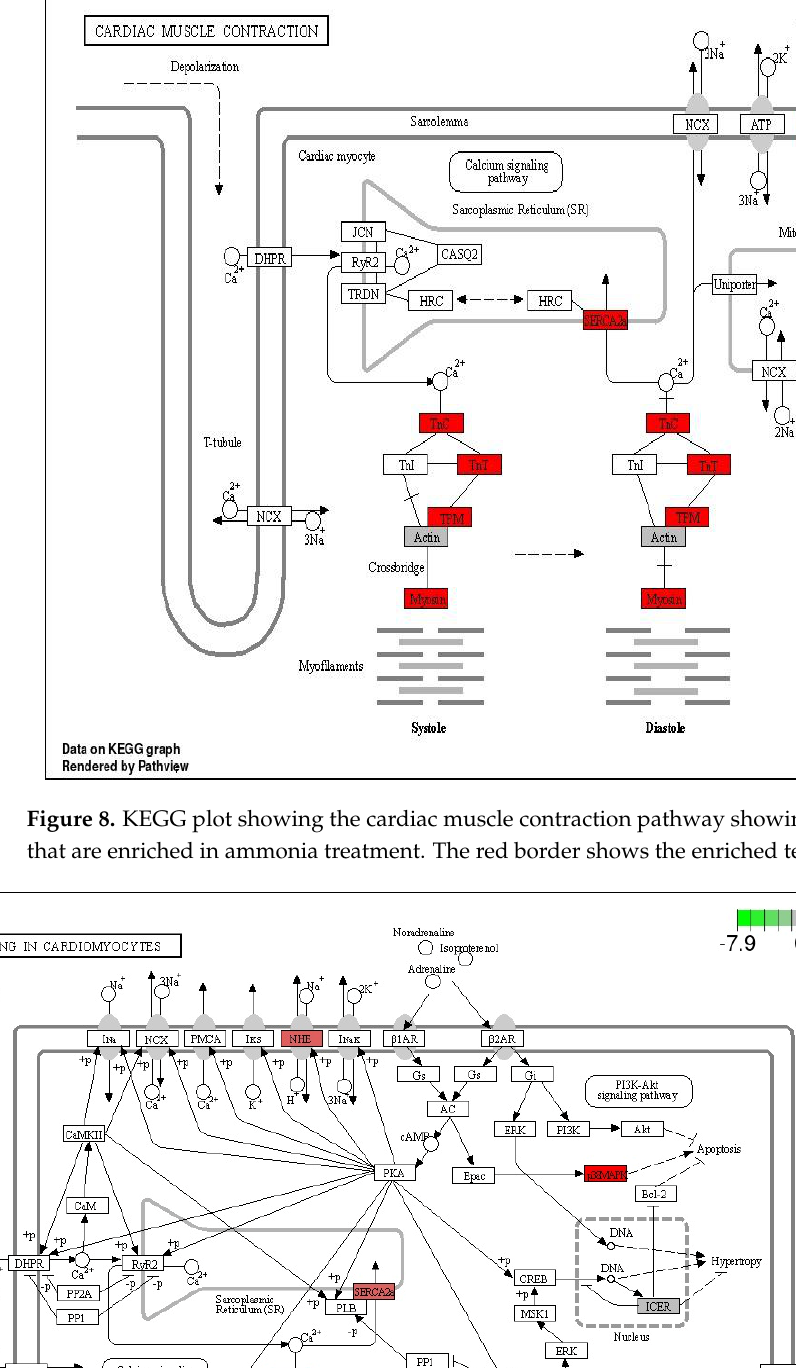
Figure 10. Fatty acid degradation pathway showing the pathway terms that are enriched in ammo- nia treatment. The color shades refer to the extent of up-regulation.